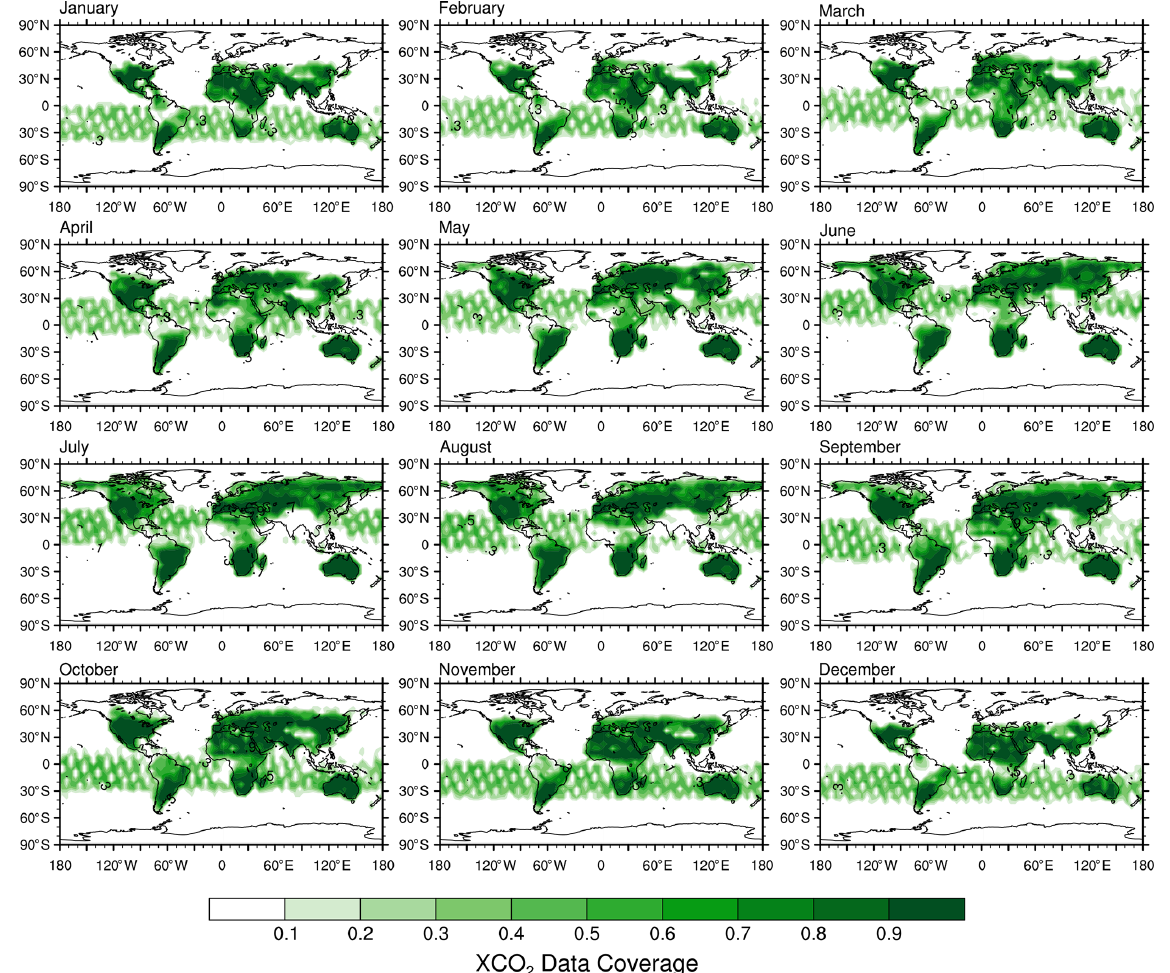
Figure 1. Mean fractional coverage of monthly satellite data for 2003–2014. A value of 0 (white) signifies no available data, while a value of 1 (dark green) means that this grid cell contains data for all years of this month. Table 1. List of active NOAA surface flask measurement sites used in this study. Code Location Latitude [ ◦ ] Longitude [ ◦ ] Altitude [m] Start year ASK Assekrem, Algeria 23.2625 5.6322 2710 1995 CGO − 40.6800 45-945